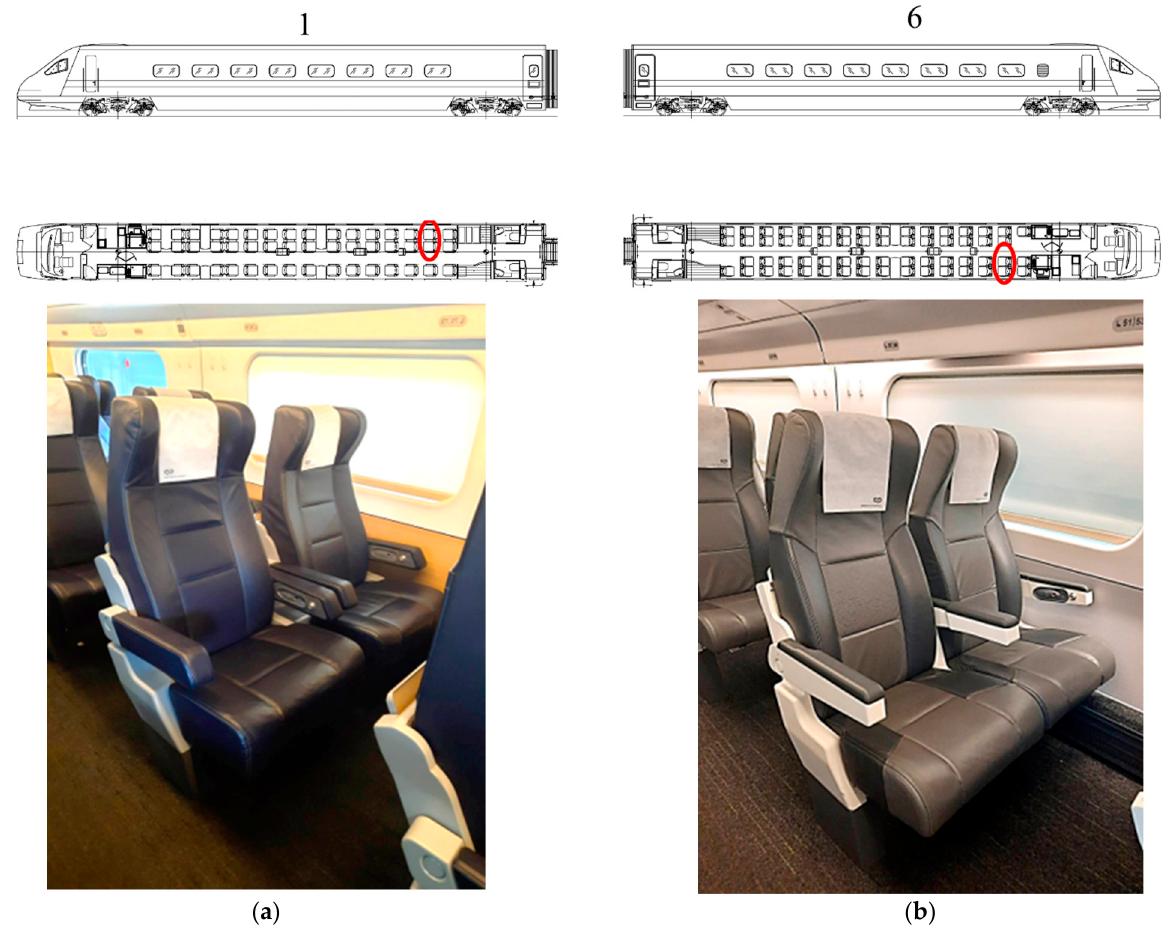
Figure 4. Alfa Pendular seats: ( a ) comfort class seat; ( b ) standard class seat.